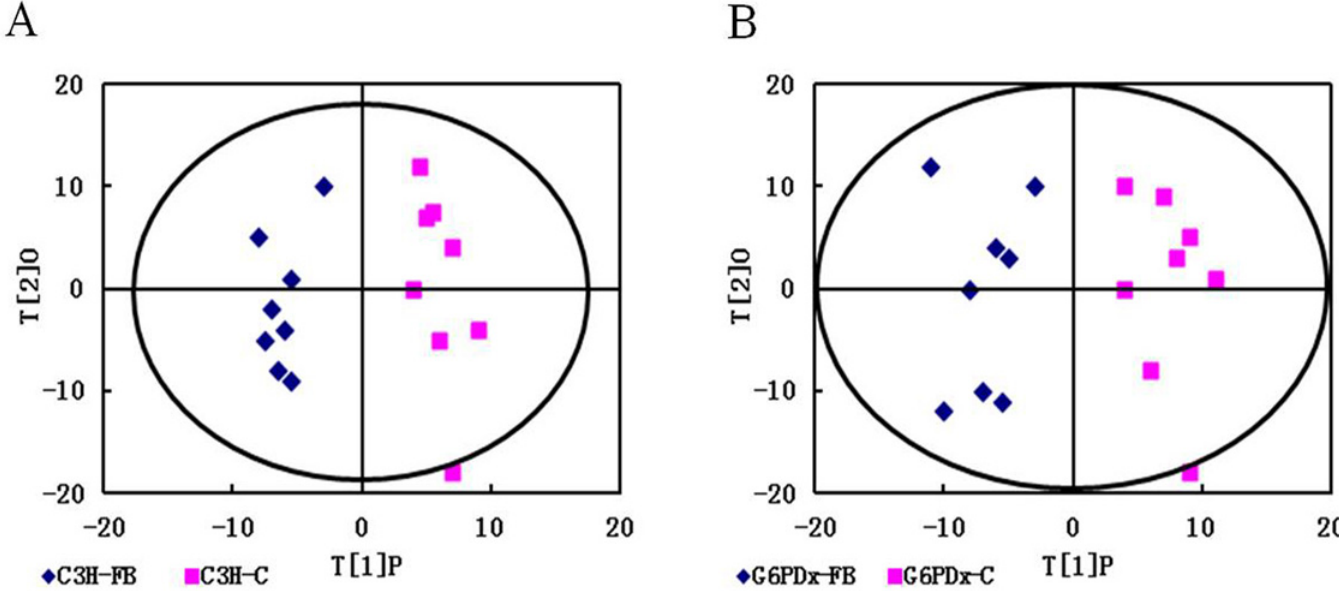
Fig 2. OPLS-DA scatter plots of GC/MS data of extracts from plasma of mice. Orthogonal partial least-squares discriminant analysis (OPLS-DA) score plots (t(1)P/ t(2)O) of the plasma of C3H group (A) and G6PDx group (B).